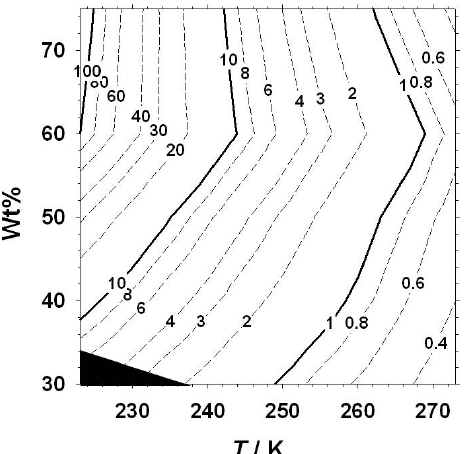
Fig. 3. Contour plots showing the calculated time in hours for the dissolution ( > 99%) of Fe 2 + ions from fayalite powder as a func- tion of temperature (223K–273K) andWt% acid solution (30%– 75%). The black shaded area indicates the conditions under which hexagonal water-ice (Ih) formation occurs in H 2 SO 4 -H 2 O solu-